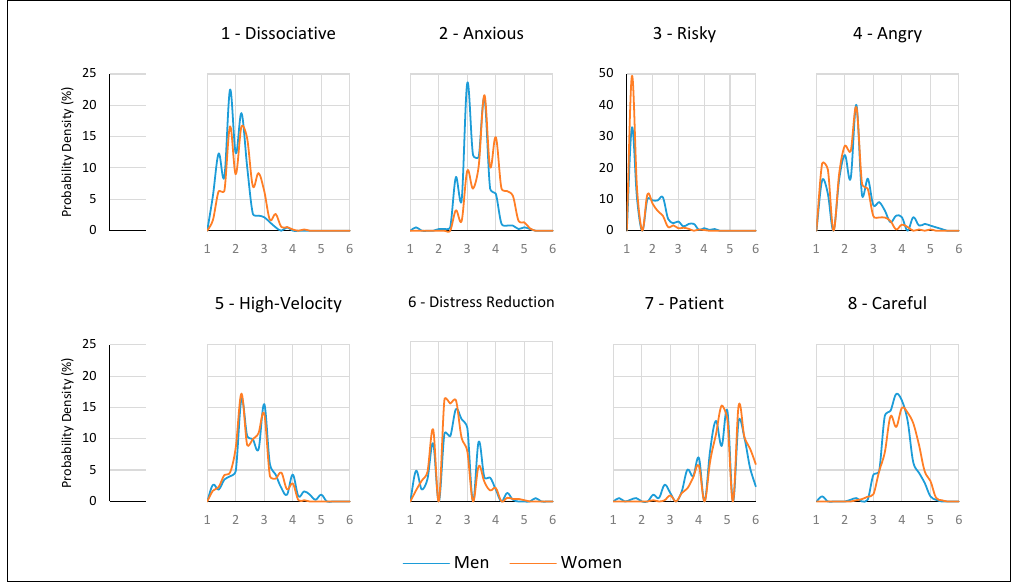
Figure 5. Distribution of self-assessment of driving style by factor and gender (notice the different scaling for Factor 3—Risky).